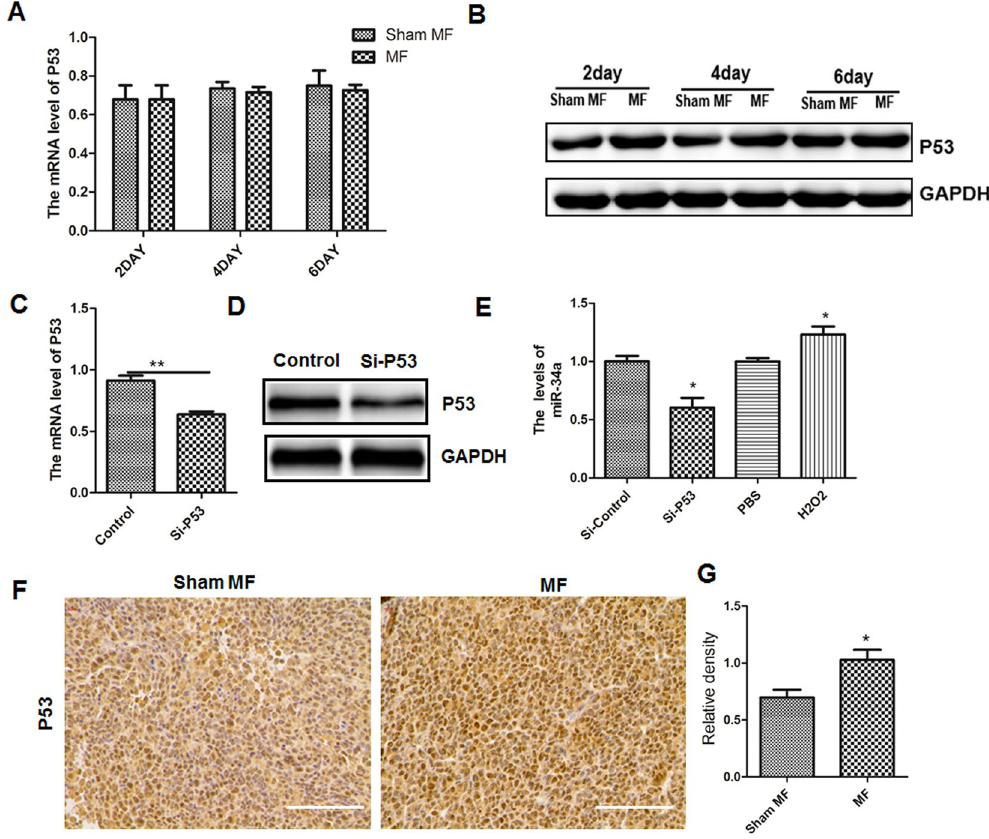
Figure 5. Low frequency MF up-regulated the expression of miR-34a by stabilizing p53 protein. ( A ) Q-PCR analyzes the mRNA levels of P53 in LLC cells treated with MF or Sham MF. ( B ) Protein level of P53 in LLC cells treatment with MF or Sham MF was detected using western Blot. ( C ) The mRNA levels of P53 in LLC cells transfected with siRNA-P53 was detected using Q-PCR. ( D ) Protein level of P53 in LLC cells transfected with siRNA-P53 was detected using western Blot. Numbers under each blot are relative intensity of the blot. (E ) Q-PCR analyzes the miR-34a level after treatment of siRNA-TP53 and H2O2. ( F ) P53 expression in tumor tissue of LLC murine model was detected using IHC staining; Scale bars, 100 µ m. ( G ) IHC images were calculated using Image Pro Plus software 6.0 and bar graphs. All experiments were repeated three times. Data represent Mean ± SEM. * P < 0.05, ** P < 0.01, *** P <